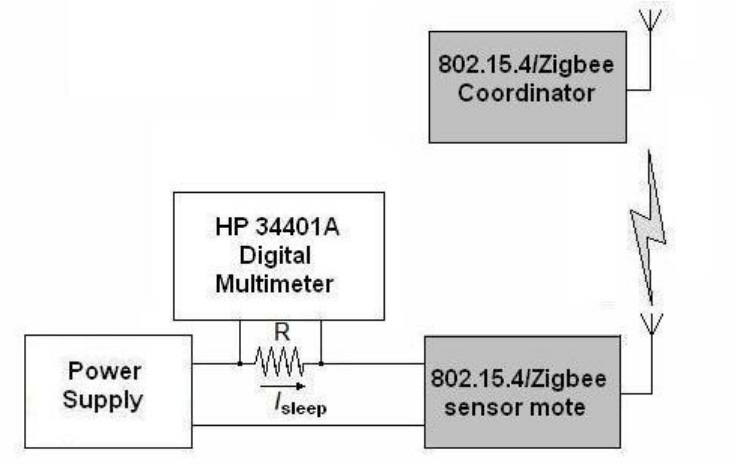
Figure 6. Experimental setup for the measurements of battery consumption during sleep mode.